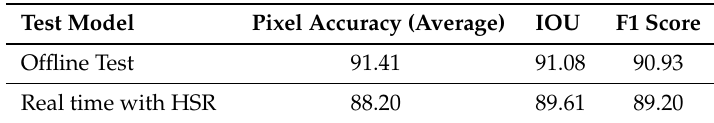
Table 3. FCN8 Performance analysis.